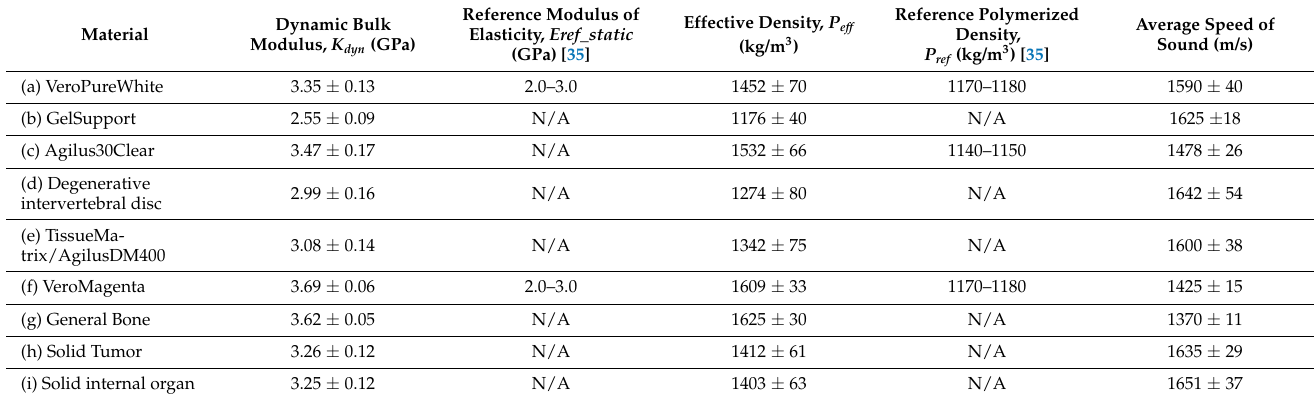
Table 1. Summary of the comparison of material properties between EBME results, such as dynamic bulk modulus, effective density and average speed of sound, and reference values, such as elastic modulus and polymerized density, given by the provider, Stratasys